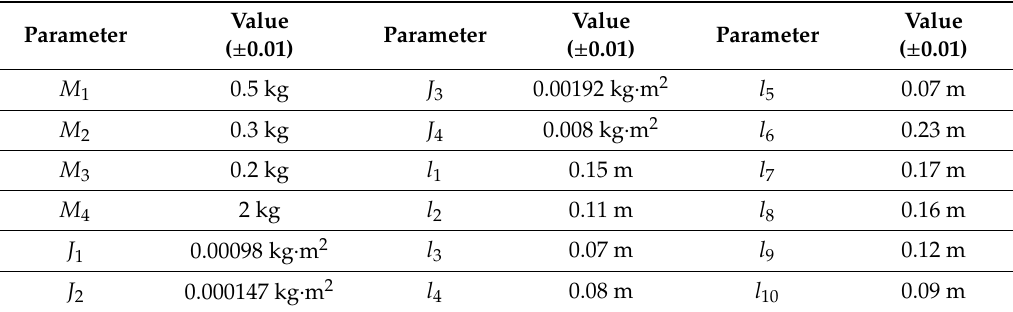
Table 1. Input parameter values from real LED